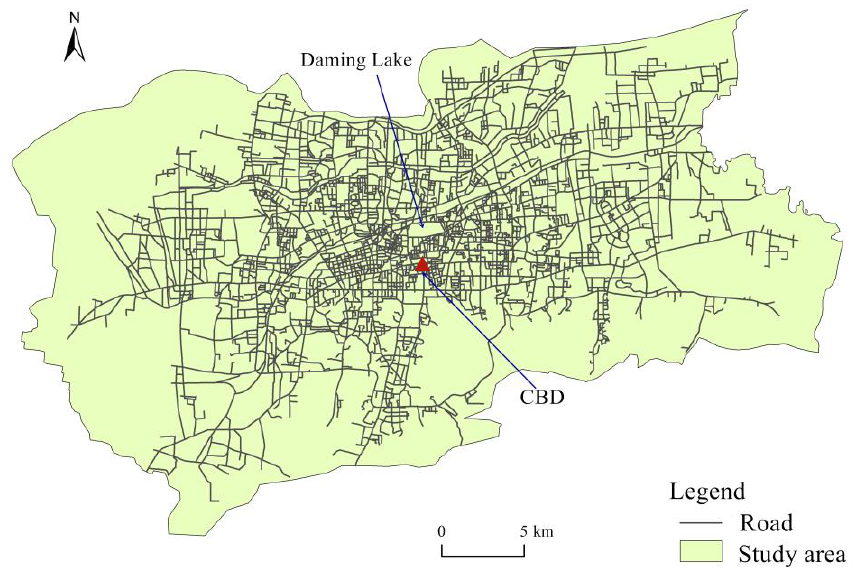
Figure 2. Distribution of road networks in the main urban area of Jinan. Table 1. Type and quantity of POI in the main urban area of Jinan.